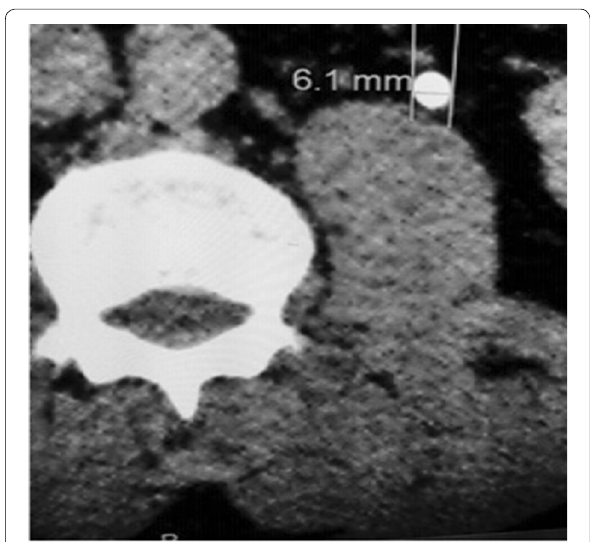
Fig. 1 Axial contrast-enhanced CT of the left ureter obtained at level L3 showing measurement of ureteral diameter